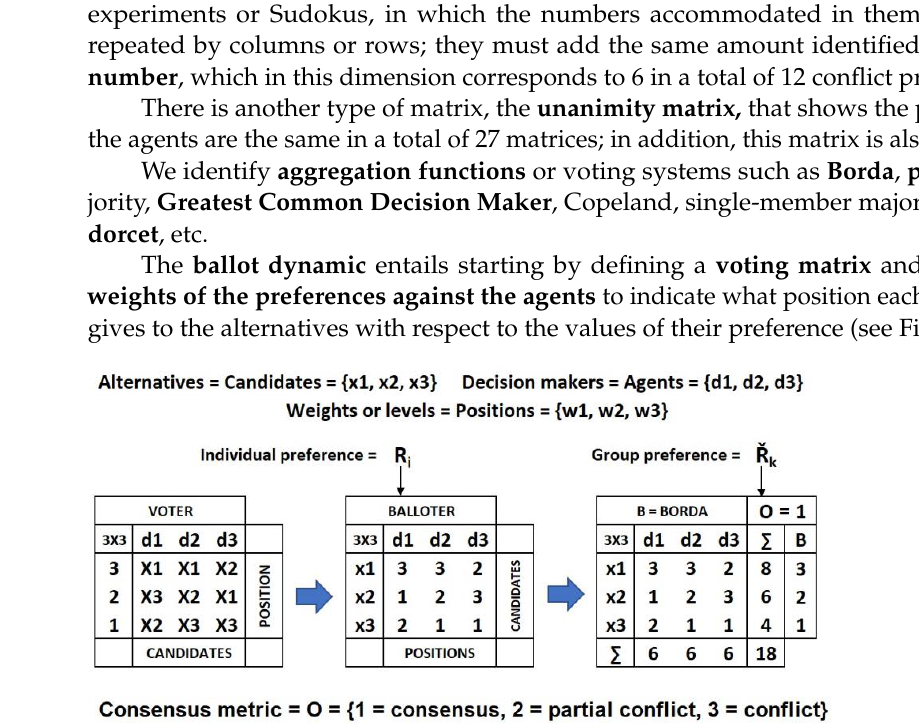
Figure 5. Ballot dynamic.